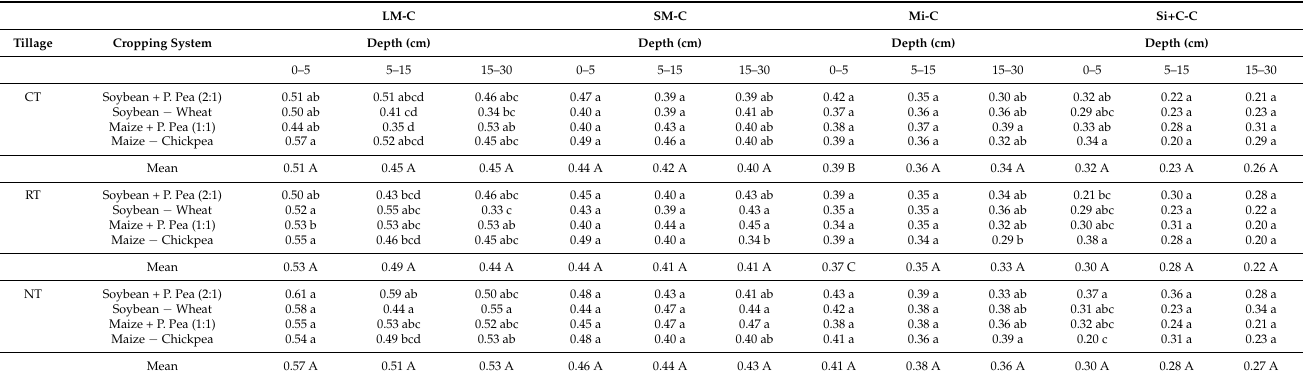
Table 4. Effect of different tillage and cropping systems on aggregate associated C concentration (%) at different soil